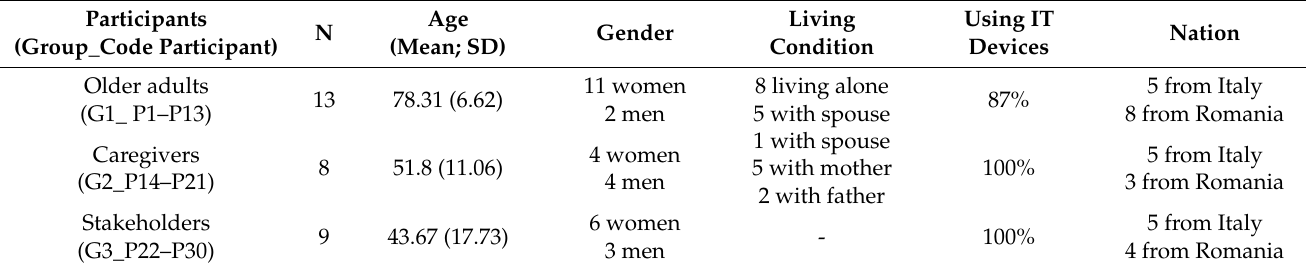
Table 1. Participants’ characteristics.